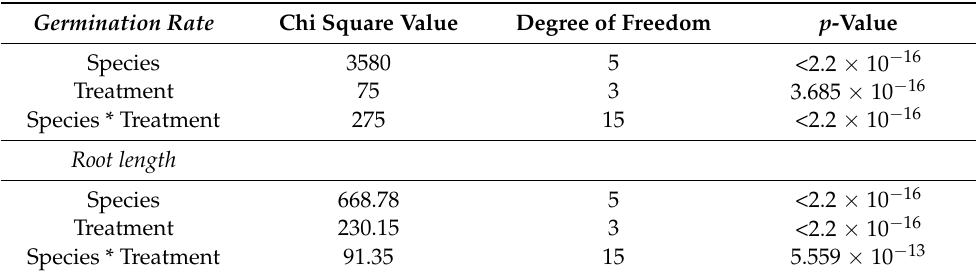
Table 3. ANOVA of the generalized linear model (glm) between species and treatments and their interaction, for the final germination rate and the root length.